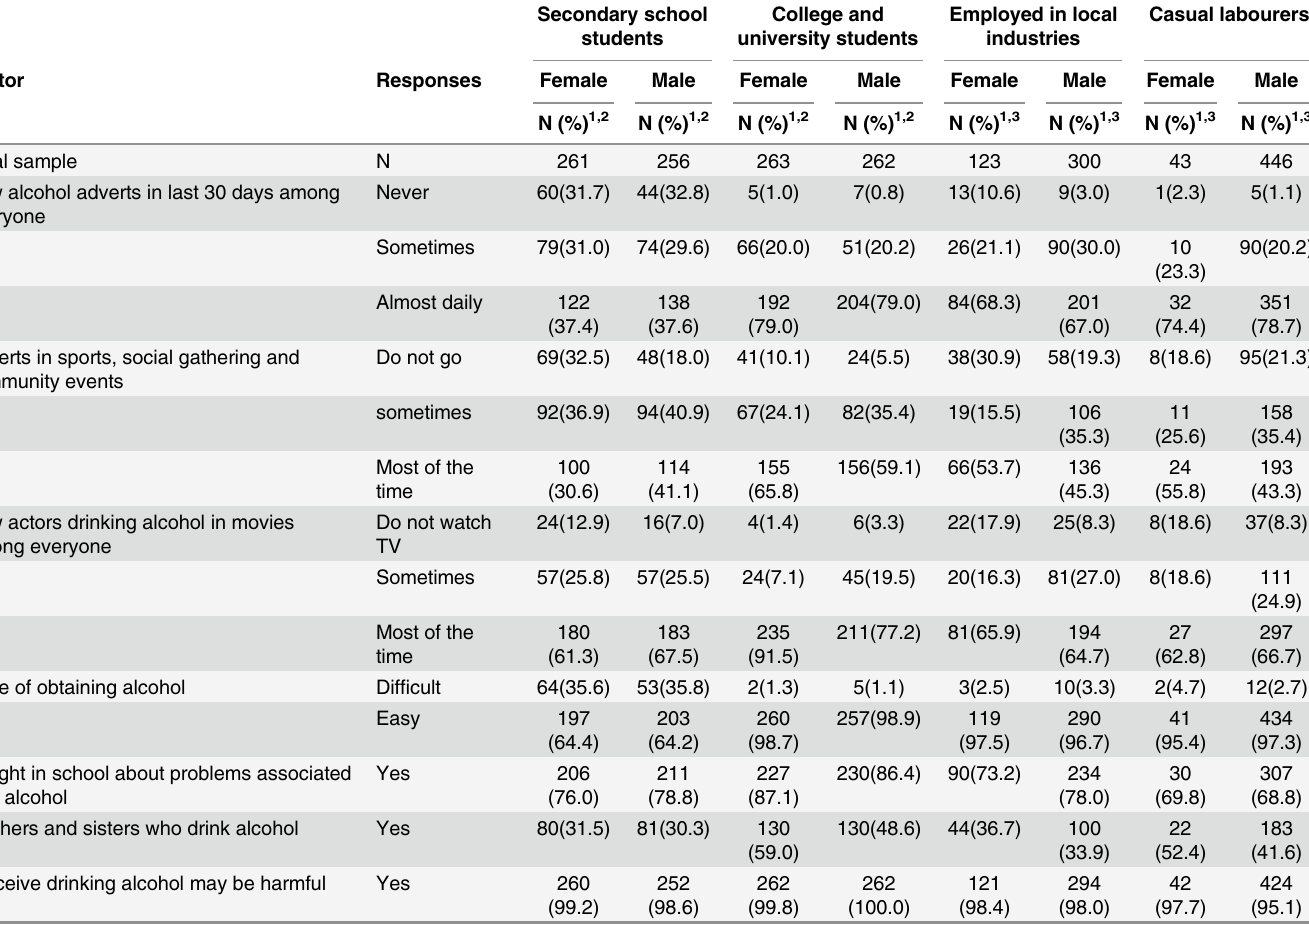
Table 2. Description of potential factors related to alcohol use among young people in northern